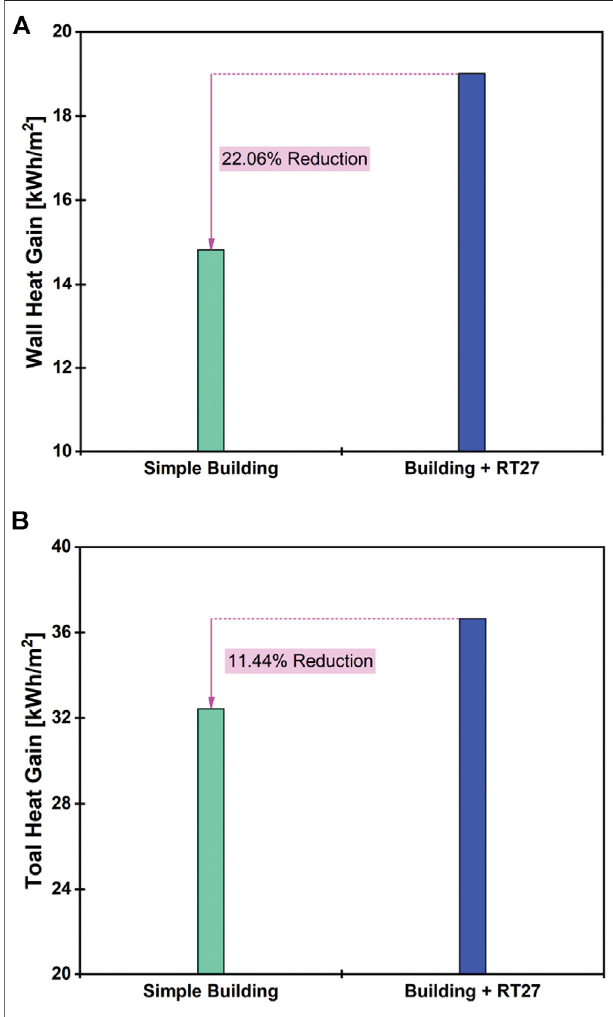
FIGURE 7 | PCM ef fi cacy on building energy usage in two conditions. (A) : wall heat gain, (B) : total heat